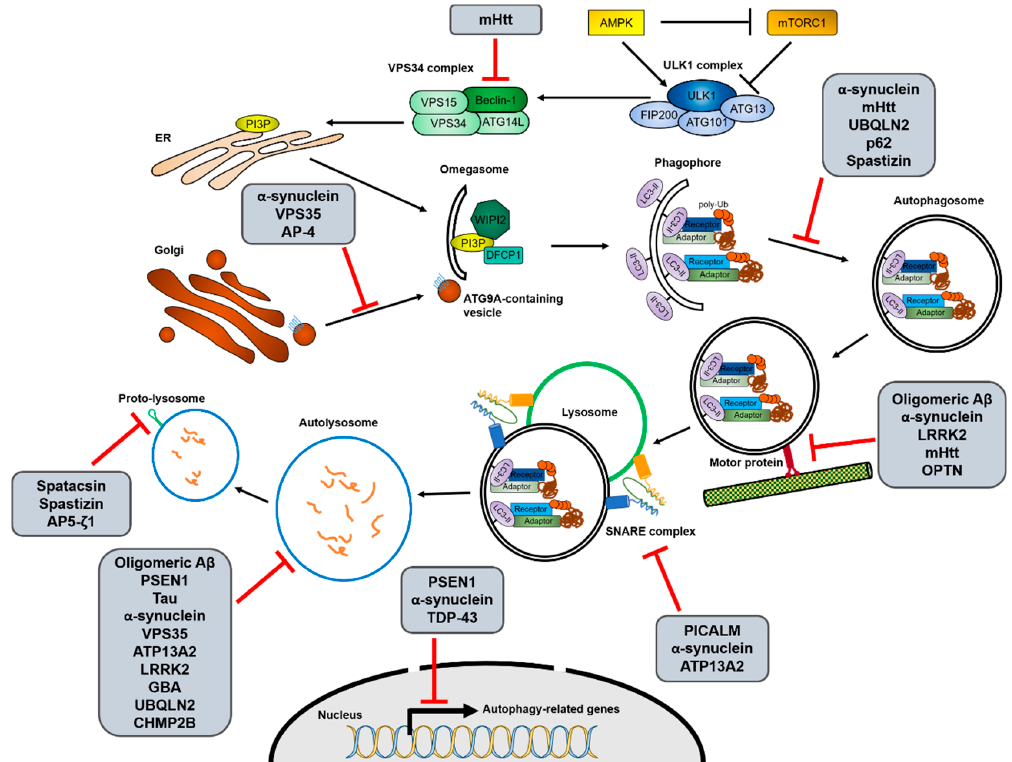
Figure 2. Interactions between the autophagy process and neurodegenerative disease-associated proteins. Increasing evidence for interactions between autophagy and neurodegenerative diseases suggests that not only the decrease of autophagic activity is one of causes of the diseases, but mutations in disease-associated genes also inhibit autophagy in various stages. The possible interruptions in each autophagic process from initiation to reformation of free lysosomes by the di ff erent neurodegenerative disease-associated mutant proteins are shown. The detailed relationships between the mutant proteins and autophagy pathway are described in Section